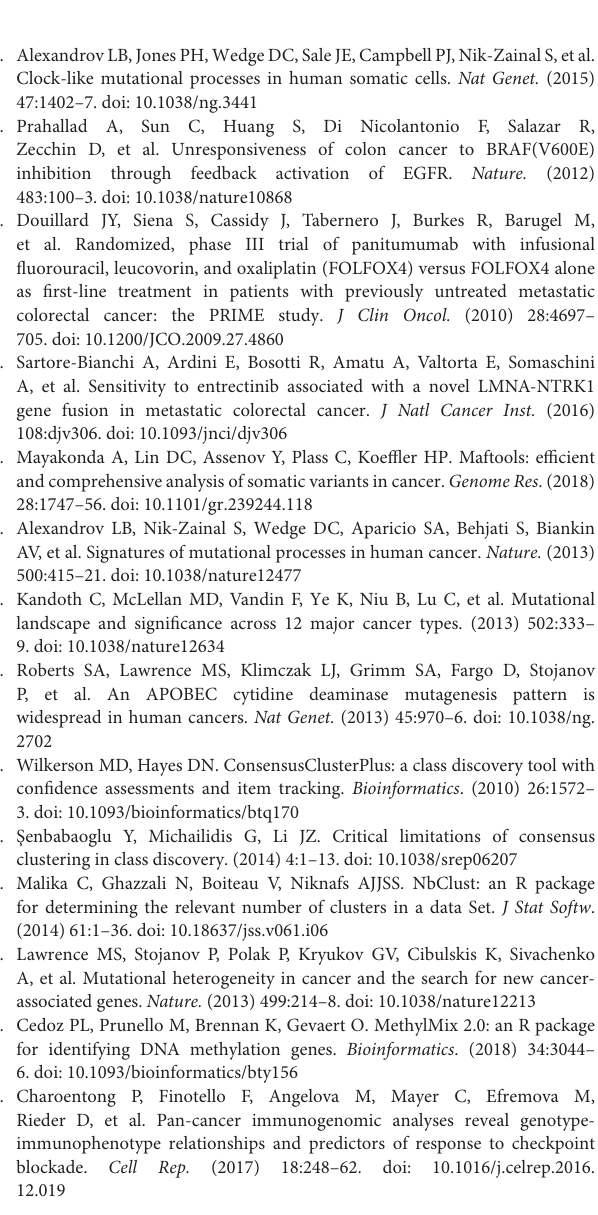
Supplementary Table 1 | Basic information of datasets included in this study. Supplementary Table 2 | The details of indicators for the assessment of immunogenicity and antigen presentation capacity. Supplementary Table 3 | The details of 75 immunomodulator molecules. Supplementary Table 4 | The qRT-PCR results and prognosis information of 30 CRC patients in our cohorts.